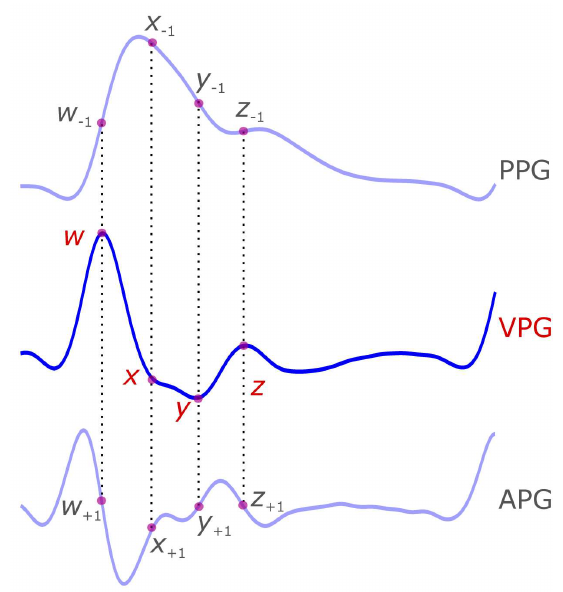
Figure 2. Demonstration of the velocity photoplethysmogram (VPG) signal and its four waveforms ( w , x , y , and z ). The four VPG waveforms are mapped on the photoplethysmogram (PPG) and the acceleration photoplethysmogram (APG) signals. The subscript of −1 indicates the location of the VPG waveform on the first integral of the VPG signal (i.e., PPG) while the +1 subscript indicates the location of the VPG waveform on the first derivative of VPG signal (i.e., APG). Note that the negative sign refers to the mathematical integration while the positive sign refers to the mathematical derivation.